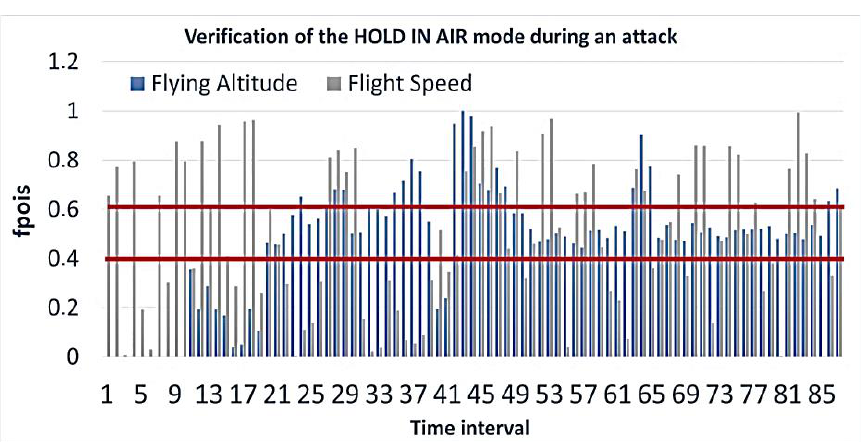
Figure 6. Verification of the HOLD IN AIR mode calculation of the cumulative function for the Poisson distribution during a cyber - attack.